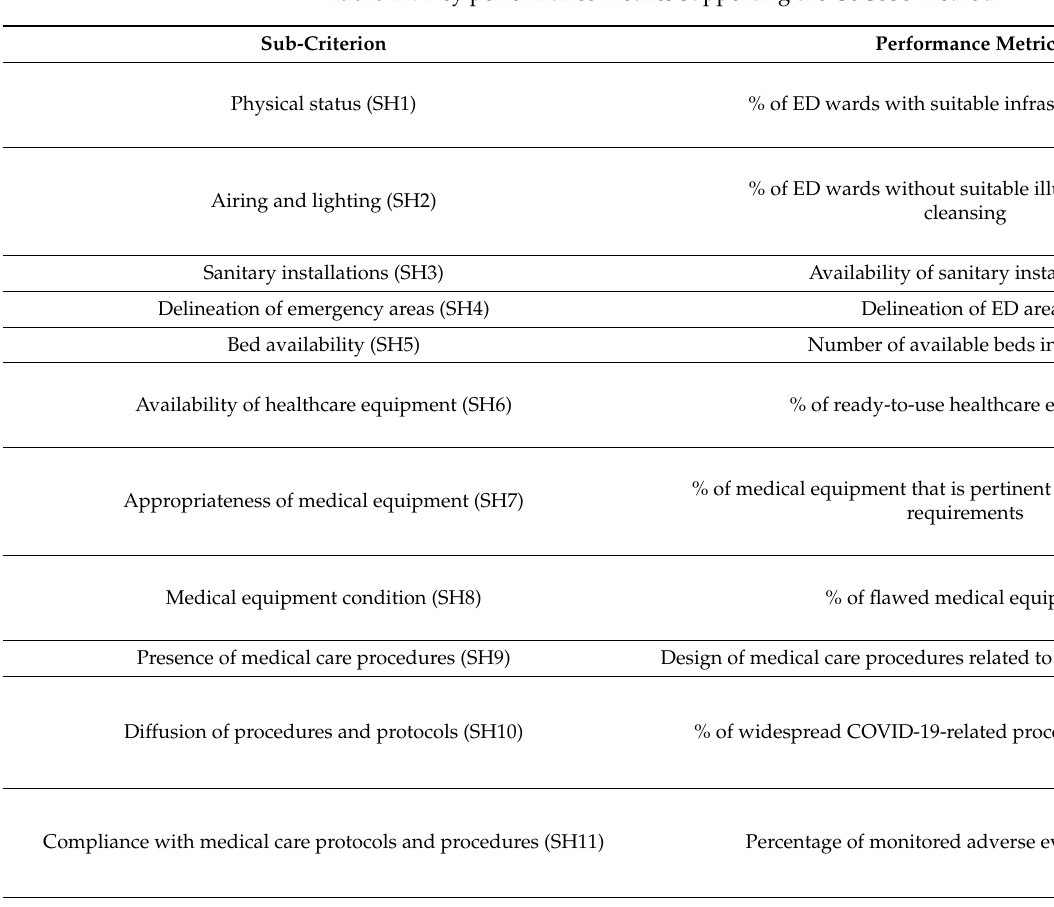
Table 12. Key performance metrics supporting the CoCoSo